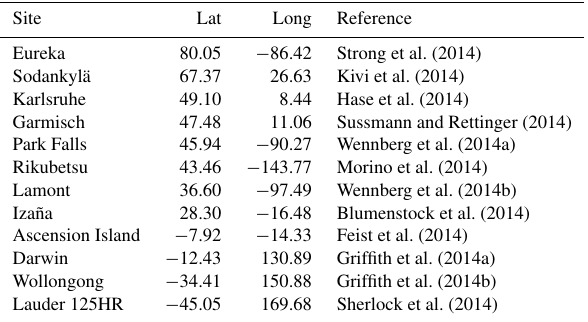
Table 2. List of the TCCON stations used in this study and ordered by latitude from north to south.